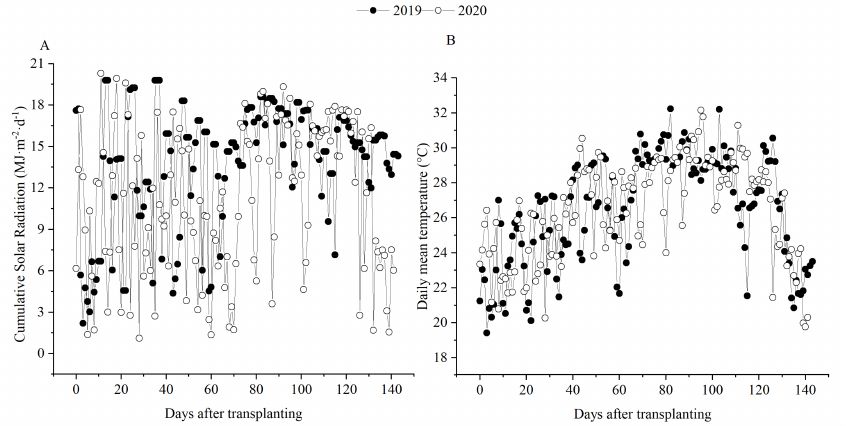
Figure 1. Cumulative solar radiation ( A ) and daily mean temperatures ( B ) during the growing season of rice in 2019 and